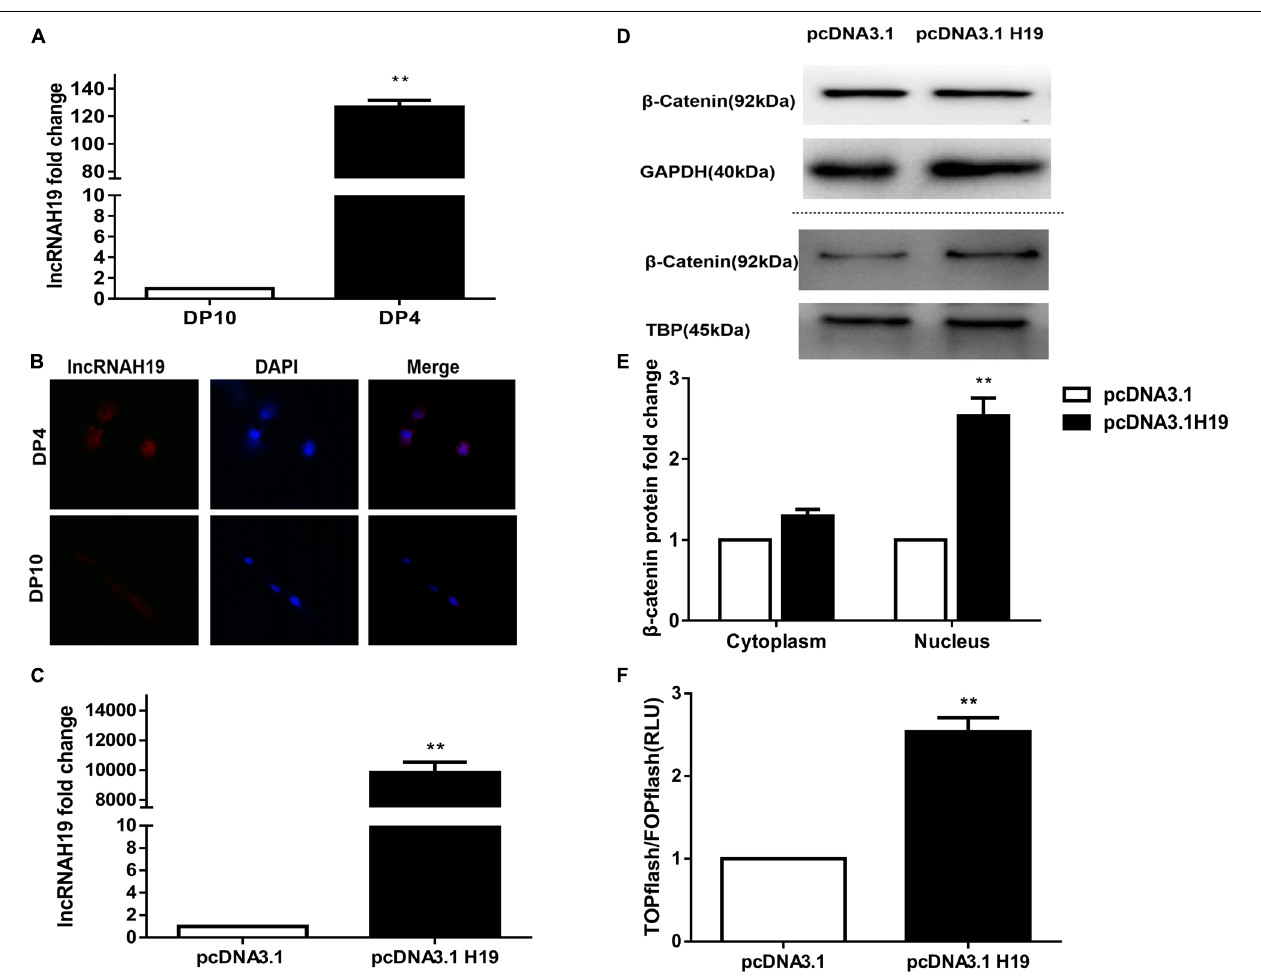
FIGURE 1 | Differential expression of lncRNA H19 between early and late passage DP cells and effect of lncRNAH19 overexpression on the Wnt/ β -catenin signaling pathway in DP cells. (A) QPCR verification the increased expression of lncRNAH19 in early passage DP cells (DP4) that show HF-inductivity ability. (B) FISH showing increased expression of lncRNAH19, in early passage DP cells (DP4), is mainly located in the nucleus ( × 40). (C) QPCR confirming that H19 was highly expressed in DP4 cells after being transfected with pcDNA3.1H19. (D,E) Compared with the pcDNA3.1 group, β -catenin expression in the nucleus was upregulated significantly after H19 overexpression ( B , upper), whereas no obvious changes could be found in the expression of β -catenin in the cytoplasm ( B , lower). (F) Luciferase reporter assay showed Wnt/ β -catenin signaling-dependent reporter gene transcription was dramatically increased after H19 overexpression in DP8 cells. Data shown represent the mean ± SEM of three independent experiments. ** P < 0.01, pcDNA3.1, mock-vehicle control group, pcDNA3.1H19 overexpression